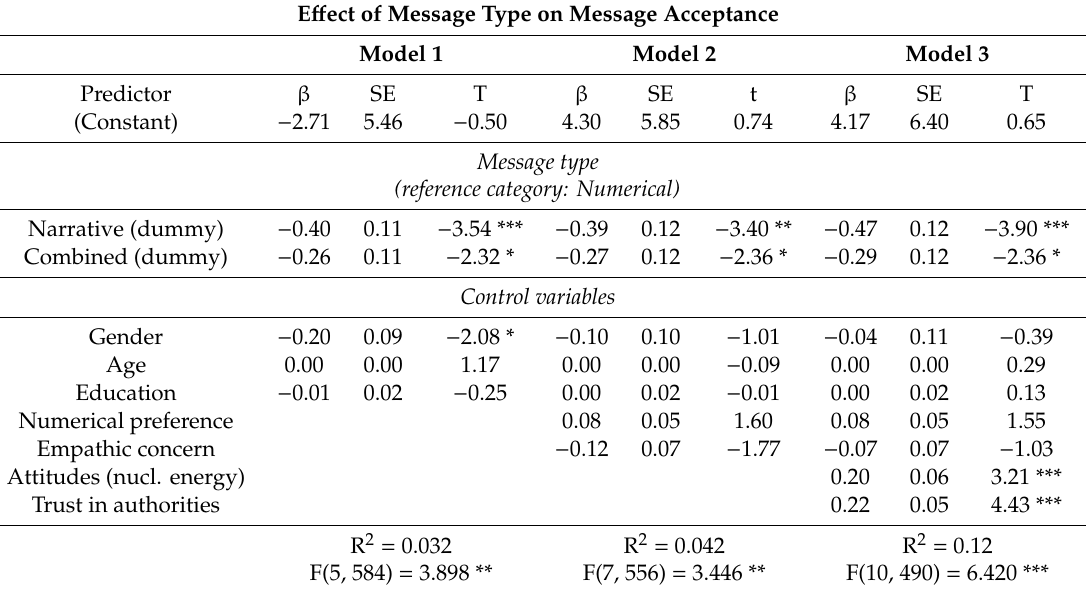
Table 3. E ff ect of message type on message acceptance.